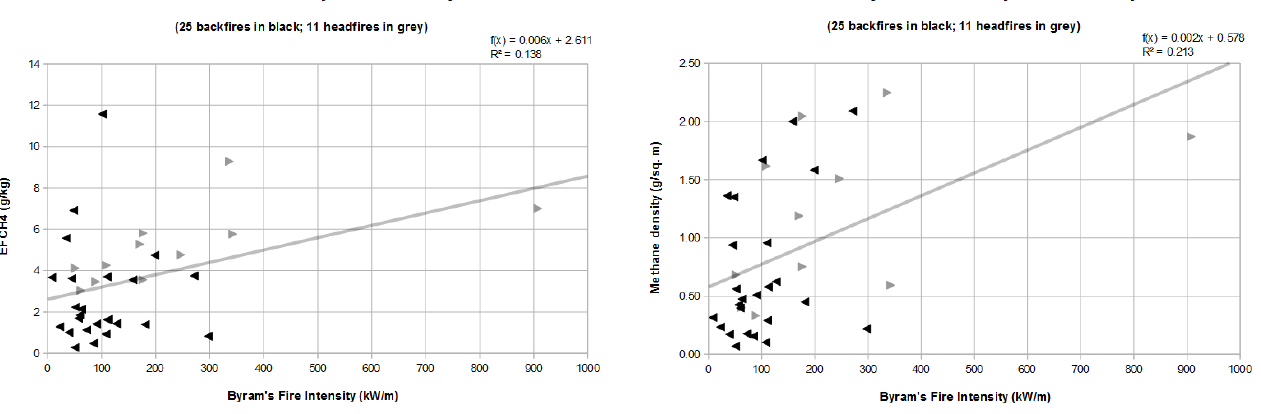
Figure 4. Methane density as a function of Byram’s fire intensity for all fires. Arrows indicate fire type (2014–2016, Mali).